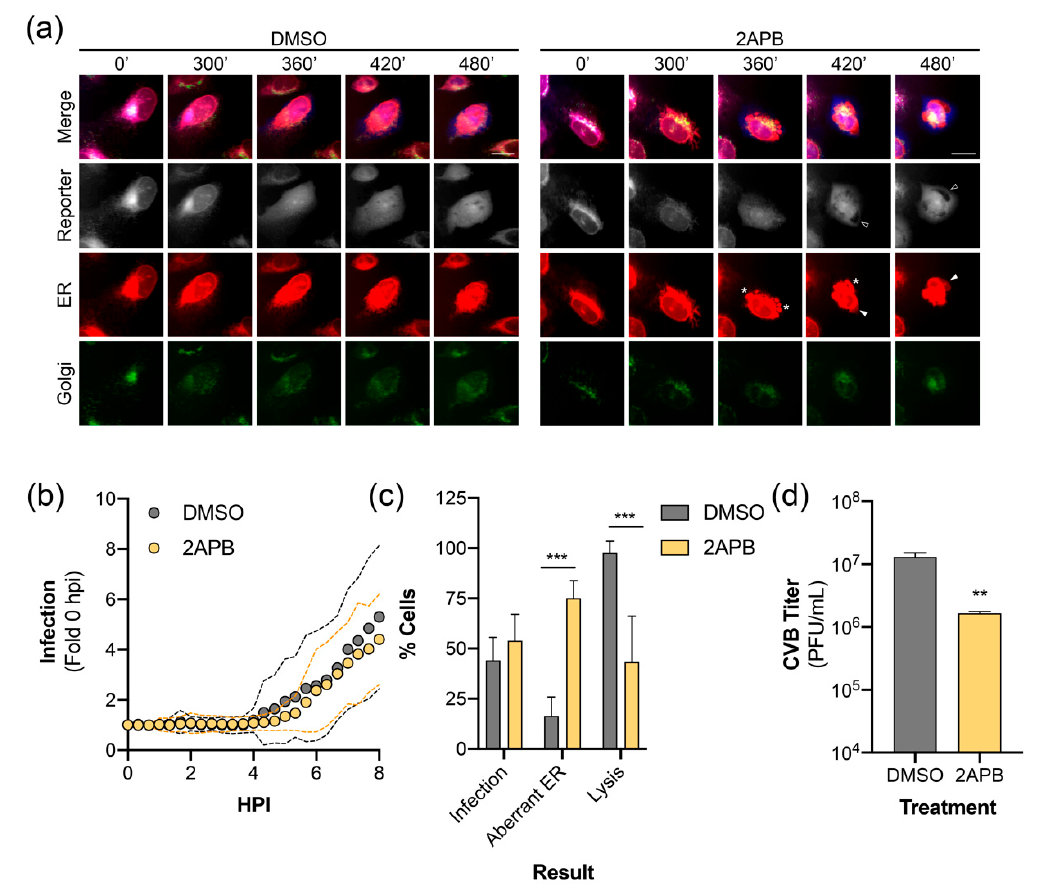
Figure 5. ER calcium channel inhibition alters CVB-induced ER remodeling. ( a ) Representative time points of an image series from live-cell imaging of mEmerald (Golgi, green), BFP (reporter, gray), mCherry (ER, red), and merged panels from U2OS cells expressing RepOr treated with DMSO or 2APB (100 µM) with CVB. Aberrant ER structures are indicated as protein aggregates (*), inflated ER (white arrowhead in ER panels), which exclude cytoplasmic BFP (empty arrowheads in reporter panels). Scale bars are 20 µm. ( b ) CVB infection kinetics of individual U2OS cells expressing RepOr treated with DMSO ( n = 24) or 2APB (100 µM, n = 24). Data is shown as the average (dots) ± SD (dashed lines) infection signal every 20 min from 0 to 8 hpi, presented as fold change compared to 0 hpi. ( c ) Phenotypes of cells from live-cell imaging of DMSO or 2APB (100 µM) treated U2OS cells expressing RepOr infected with CVB. Data is shown as the percentage of cells showing nuclear translocation of the reporter at 8 hpi (Infection), percentage of cells showing infection containing aberrant ER structures (Aberrant ER), or the percentage of cells showing reporter translocation at 8 hpi that resulted in lysis by 16 hpi (Lysis), as determined by loss of reporter signal upon loss of membrane integrity (as described in Materials and Methods 2.8.5). The data was collected from two independent experiments, with four separate fields/experiment. Significance was determined by one-way ANOVA, *** p < 0.0005. ( d ) Titer of extracellular virus from CVB infected U2OS cells treated with DMSO or 2APB (100 µM) at 10 hpi. The data is shown as the average ± SD titer (PFU/mL) from three independent experiments. Significance was determined by student’s t -test, ** p < 0.005.